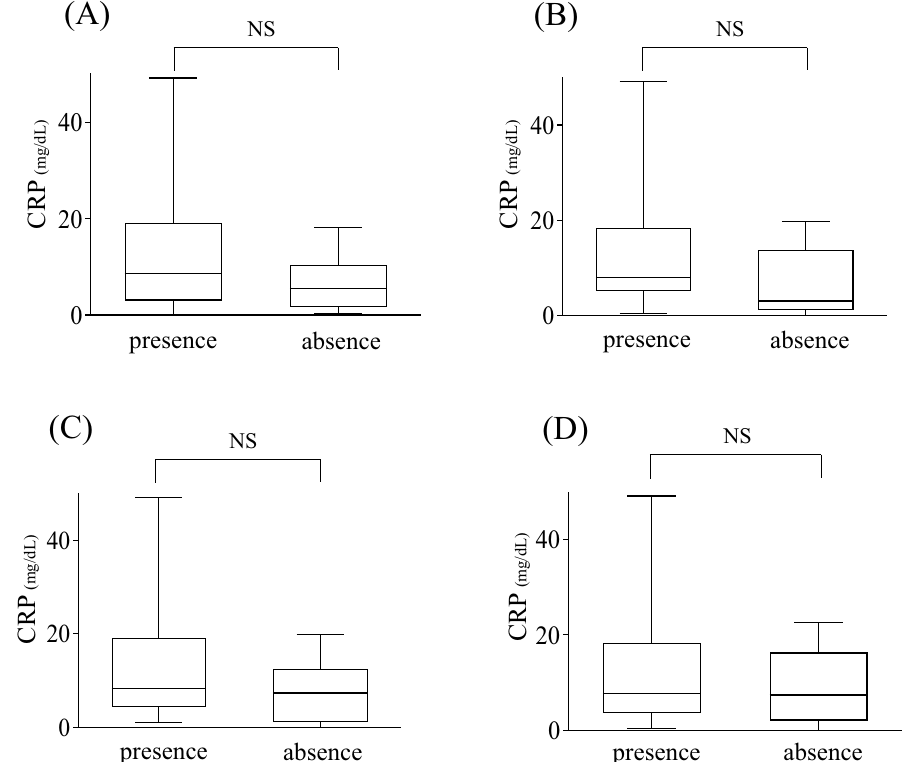
Figure 3. Comparison between C-reactive protein (CRP) levels of patients with presence and absence of local findings in periprosthetic hip infection (PHI). The significant difference of CRP was not shown between two groups in PHI. Pain ( A ), swelling ( B ), hyperthermia ( C ), and sinus tract ( D ). NS no significant difference.